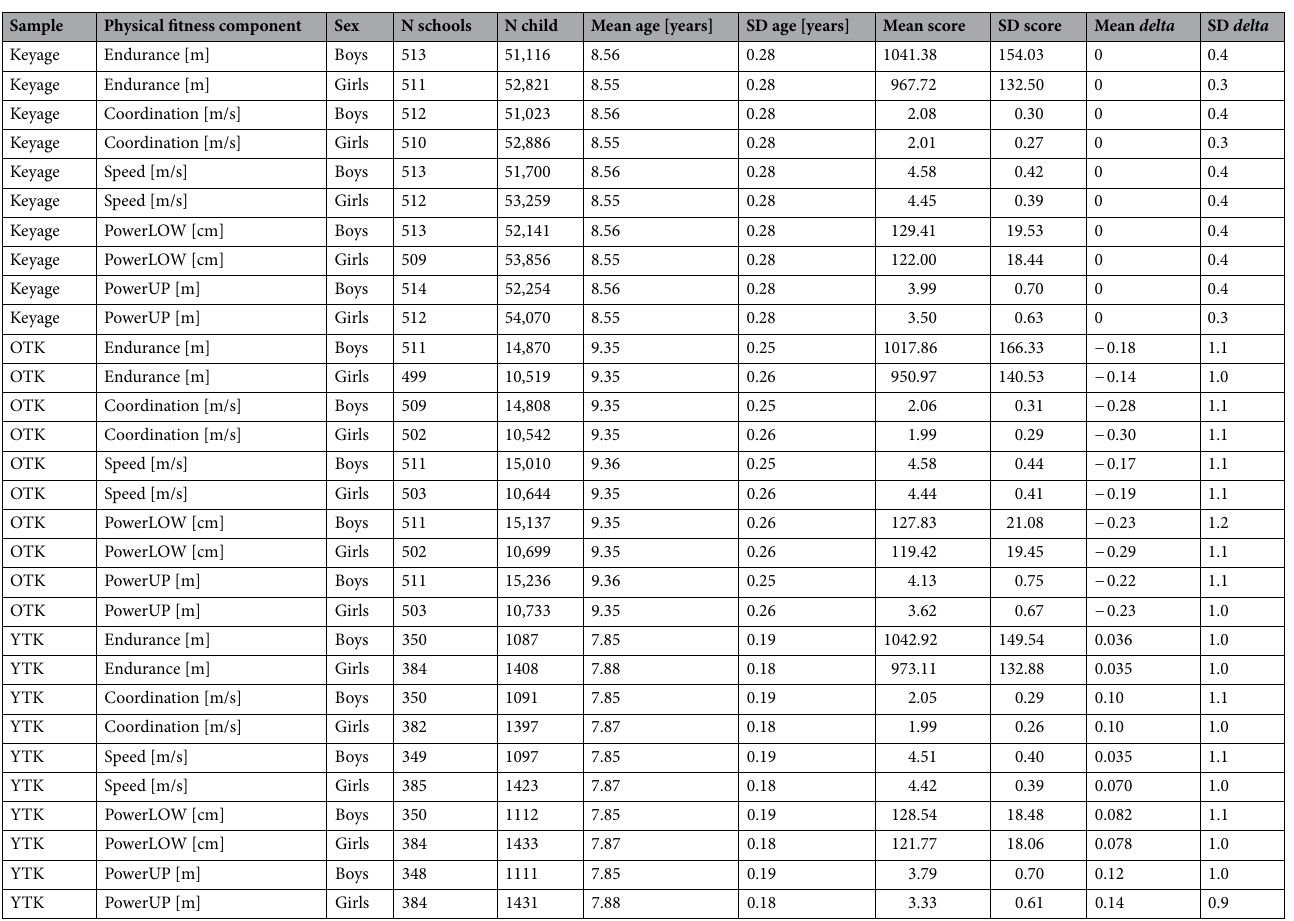
Table 1. Descriptive statistics for younger-than-keyage, keyage, older-than-keyage children. N = sample size, SD = standard deviation, delta = difference between observed (i.e., obtained through